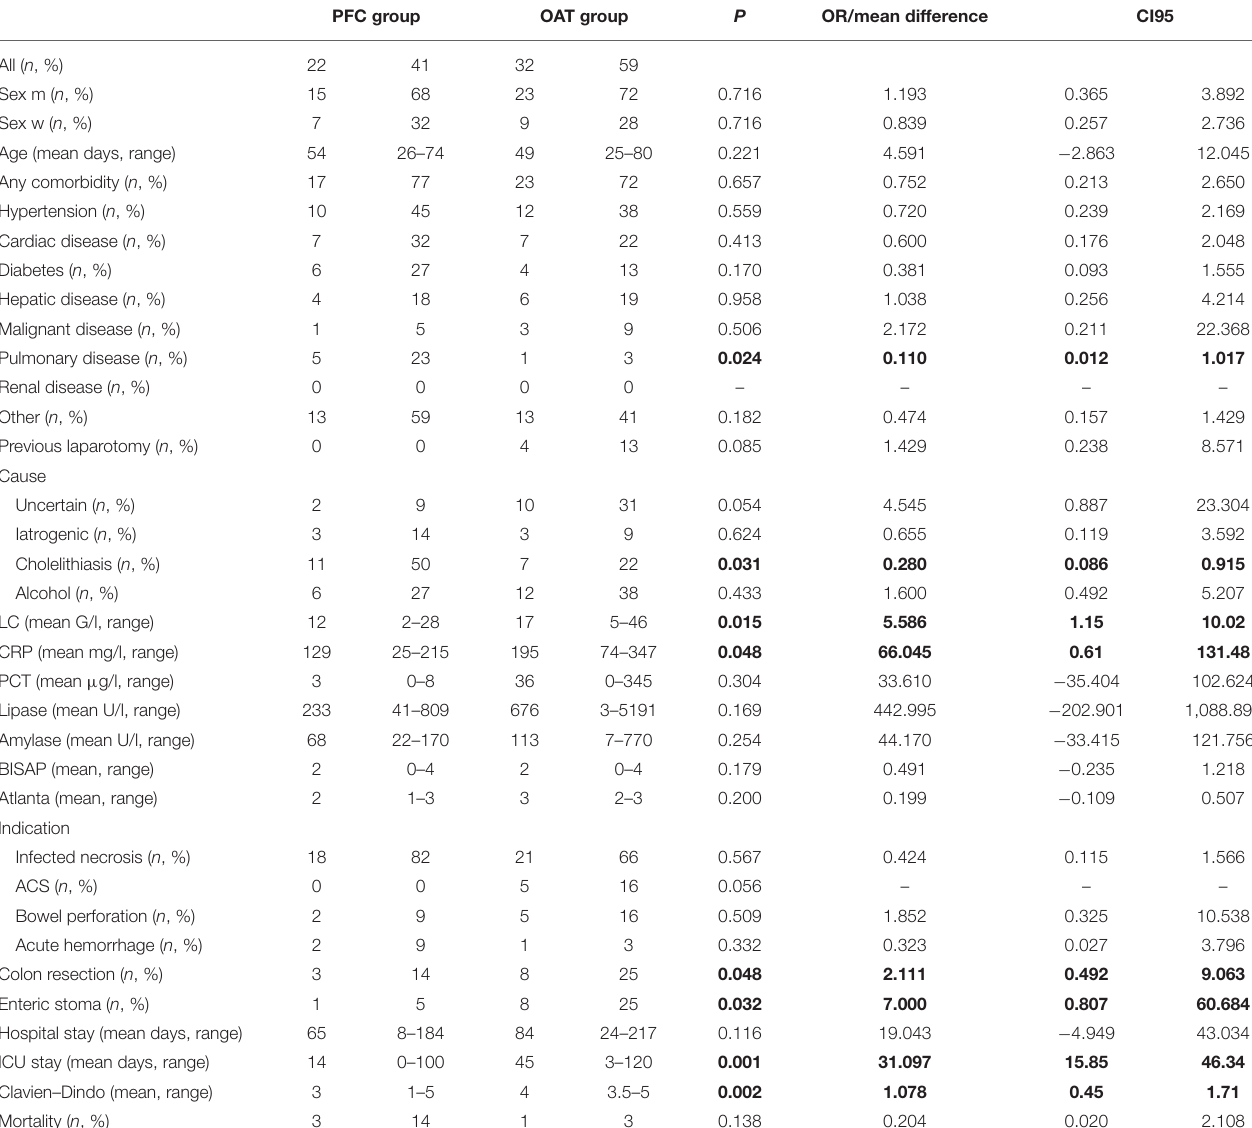
TABLE 1 | Baseline characteristics of all patients, divided into PFC and OAT group. PFC group OAT group P OR/mean difference